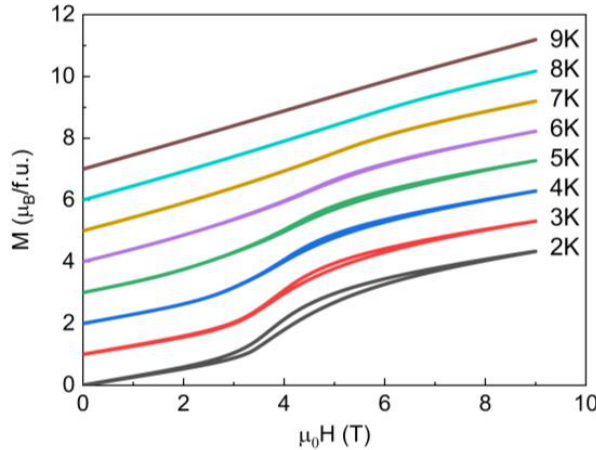
Figure 4. Magnetization curves measured for Ba 2 Mn 3 (SeO 3 ) 6 at selected temperature in the T < T N and T N < T < T corr regions. For clarity, the curves are shifted with respect to each other by 1 µ B /f.u.